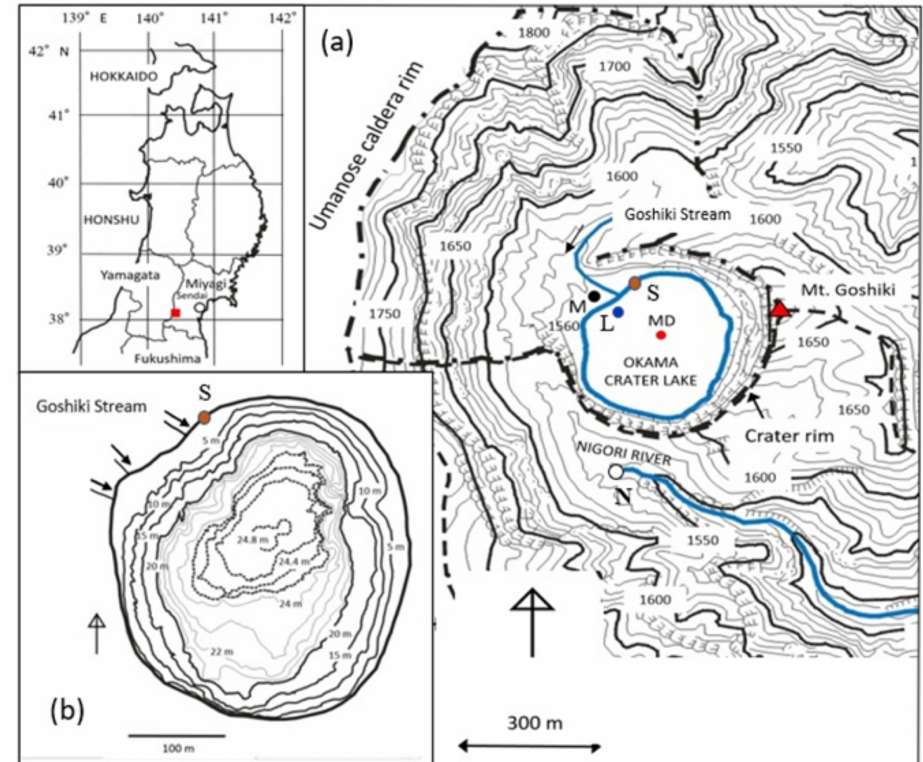
Figure 1. Location of the study area (red square on the upper left map) in Miyagi Prefecture, Japan, and ( a ) location of observation sites (site L: lake level, site M: meteorology, site S: water sampling: site MD: mooring system) in the catchment on the topographic map (10 m contour). Site MD is the deepest point of Okama Crater Lake. The dot-dashed line shows a water divide of the Okama including the peak (red triangle) of Mt. Goshiki, and the dashed line indicates the uppermost part of the water divide of the Nigori River. River water sampling was performed at site N. ( b ) The bathymetric map of the Okama accompanied by three inflowing streams [7] and the whitish water inflow at site